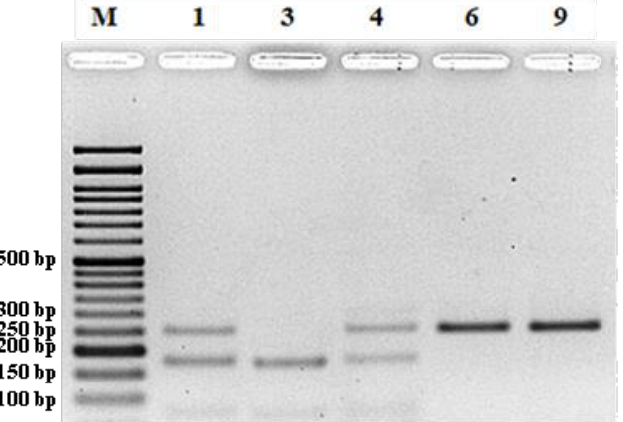
Figure 5. Agarose (3%) gel electrophoresis analysis of the molecular patterns of 5 accessions for the DiploTSNP.290 locus. Accessions 1 and 4 (Heterozygous Y/N); Accession 3 (Homozygous Y/Y); Accessions 6 and 9 (Homozygous N/N); M — DNA ladder VI (Nzytech). Y — one allele restricted; N — one allele not restricted.